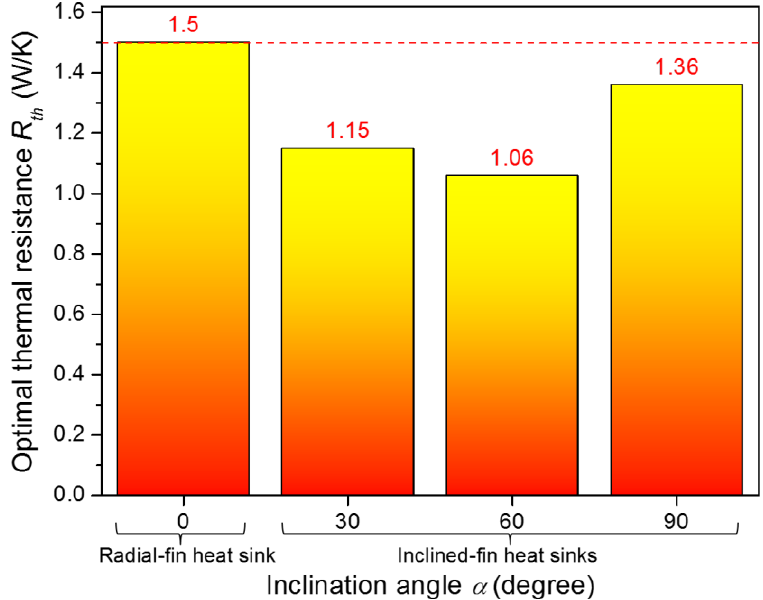
Figure 12. Comparison of the thermal resistances between the optimized inclined fin heat sinks and the optimized radial fin heat sink (9 < N < 36, t < 2 mm, H = 30 mm, D = 60 mm, L = 50 mm, T w − T amb = 50 °C, k f = 0.026 W/m K, k s = 220 W/m K, ν f = 1.6 × 10 −5 m 2 /s, α f = 2.23 × 10 −5 m 2 /s, β f = 0.0033/K).